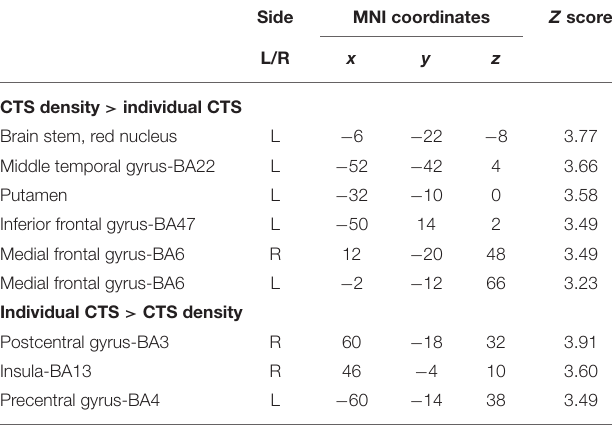
List of brain regions showing BOLD signal increases related to the CTS density vs. individual CTS model and vice versa (p < 0.001 uncorrected, 10 voxels extent threshold). BA, Brodmann area; L, left; R, right.